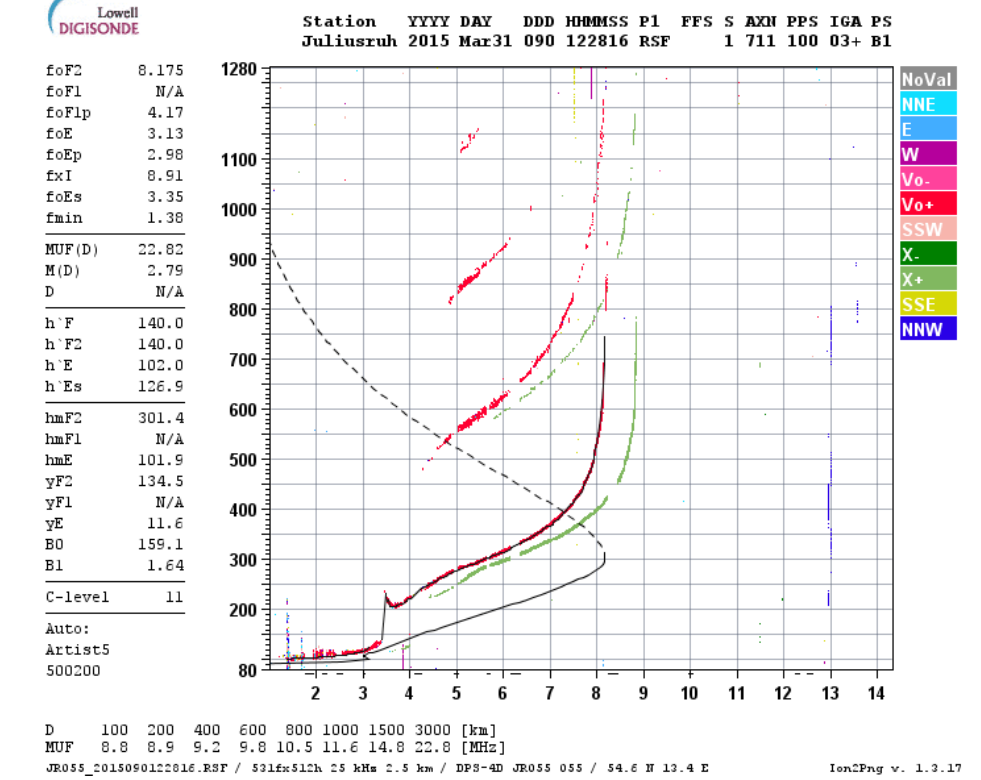
Figure 46. Ionogram by DPS-4D, Juliusruh, 31 March 2015. On the left side some of the automatically scaled characteristics. The black trace is the real-height profile of the plasma frequency, calculated from the ionogram in real